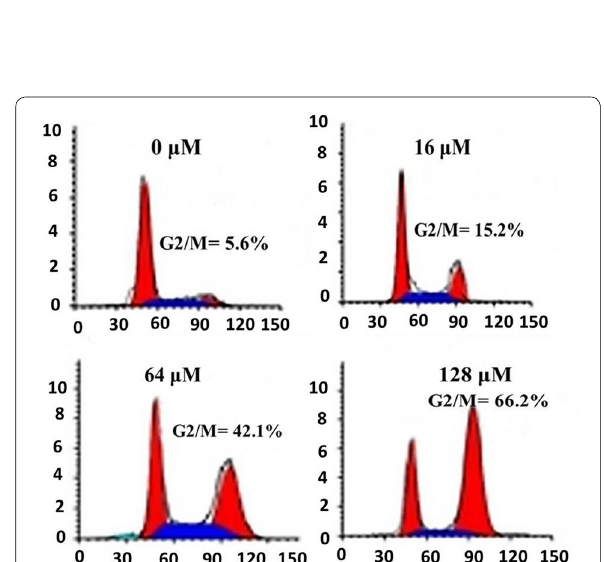
Fig. 7 Flow cytometric analysis of HeLa cells after being subjected to garcinone-E at indicated doses. Individual separate experiments were implemented three times considering p < 0.05 as statistically significant and data was signified as ±